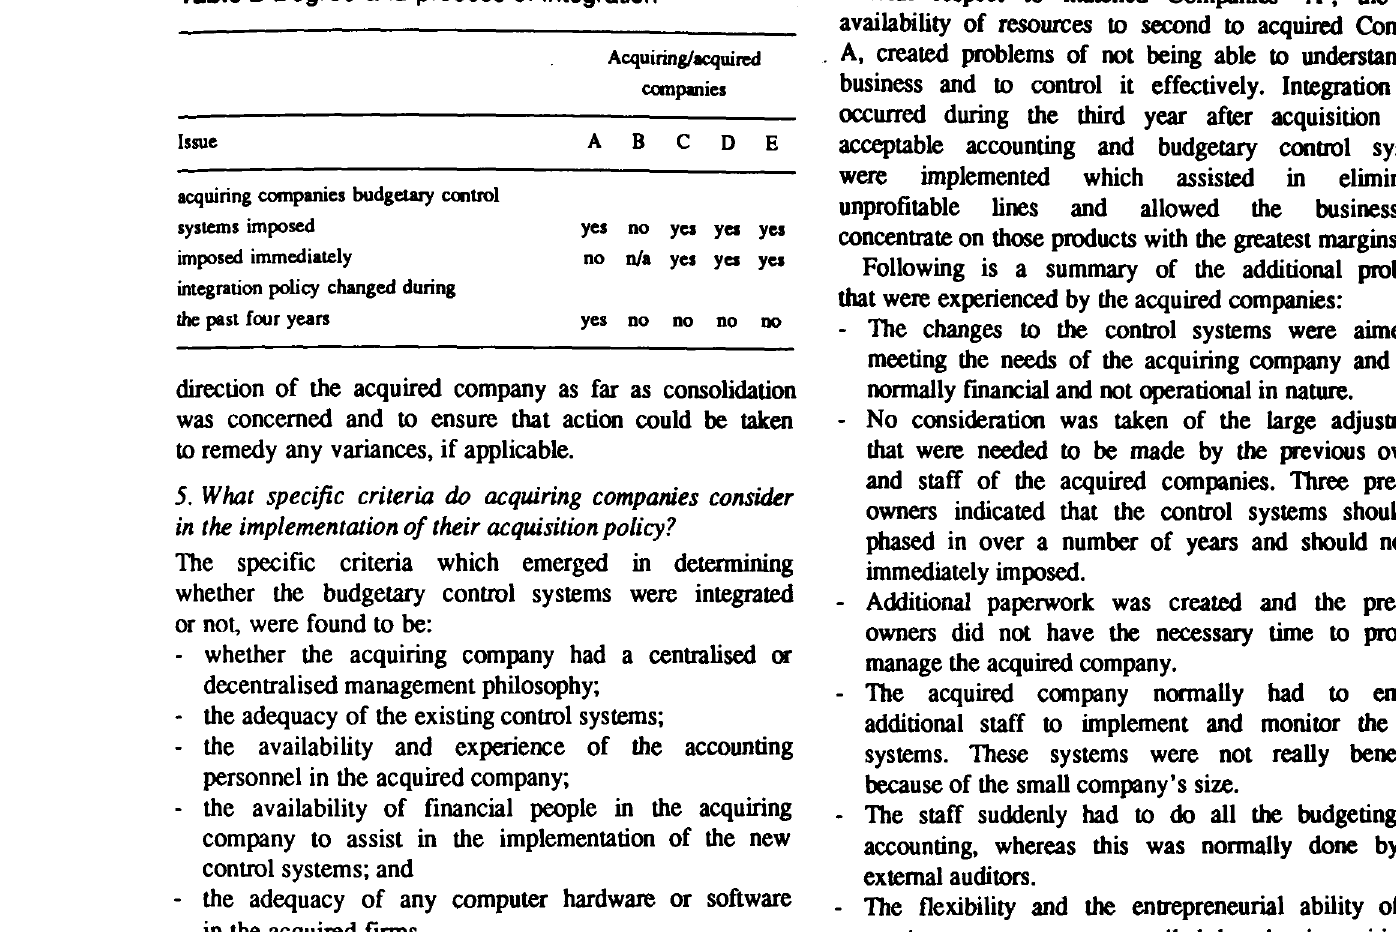
Table 2 Degree and process of